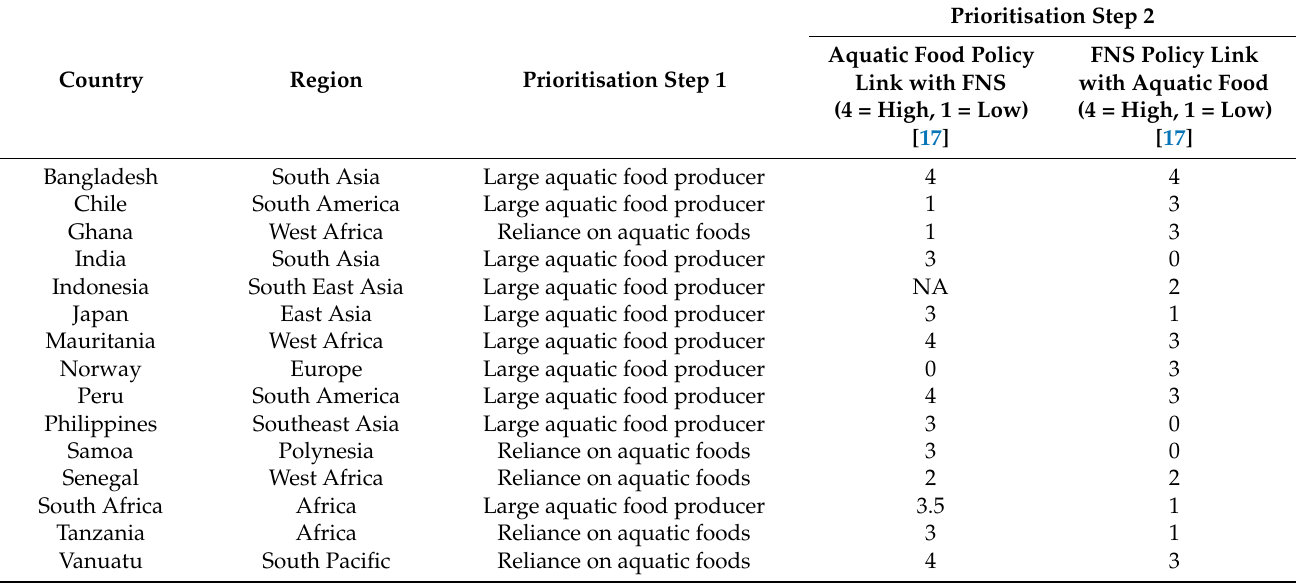
Table 1. List of countries selected for review based on the results of two-step